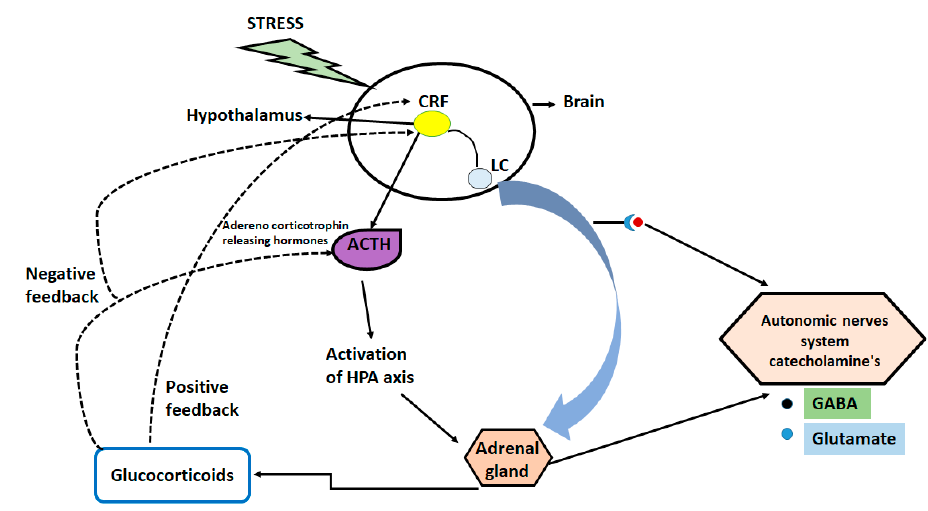
Figure 1. Mechanistic pathway of stress induced disturbance in